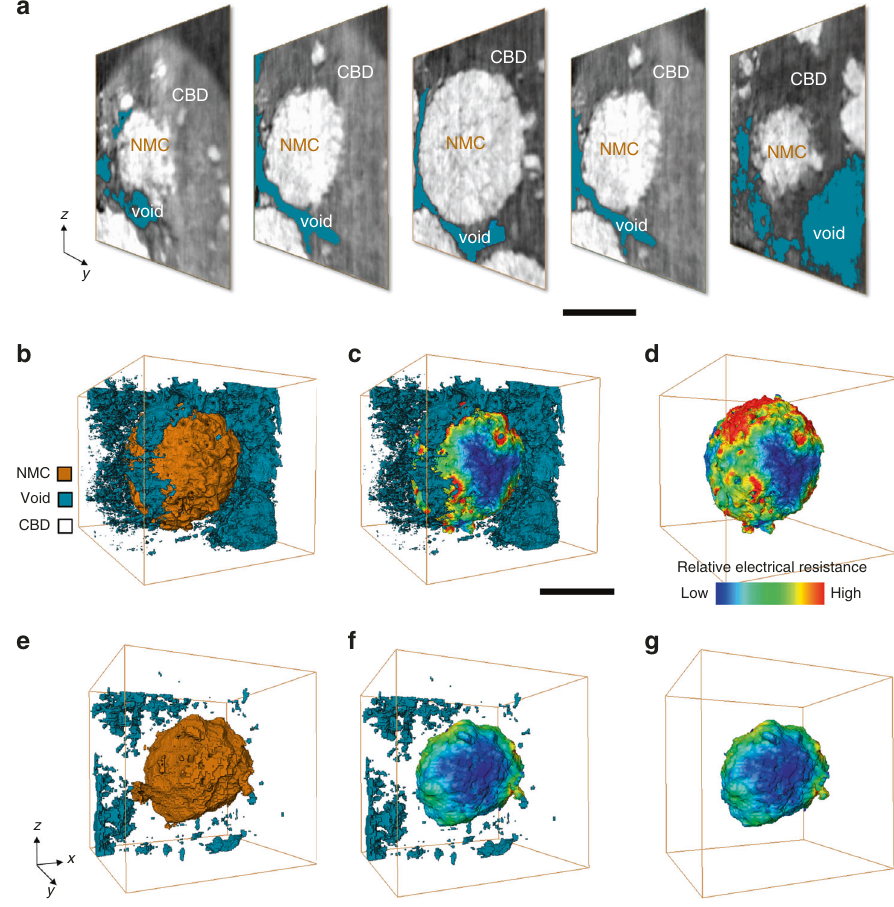
Fig. 2 Visualization and modeling of the particle detachment. a Selected y – z slices through an NMC particle. b , e The 3D rendering of the segmentation results over two regions of interest, with the CBD set to be transparent for a better visualization of the NMC particle (orange) and the voids (gray – blue). c , f The renderings of the calculated distributions of relative local electrical resistance over the surface of the particles in ( b ) and ( e ), respectively. Our modeling result suggests a strong correlation between the degree of CBD attachment and the level of calculated electrical resistance heterogeneity. d , g The same particles of the ( c ) and ( f ) presented without the void phase. The scale bar in ( a ), ( c ), and ( f ) are 10, 10, and 5 μ m,